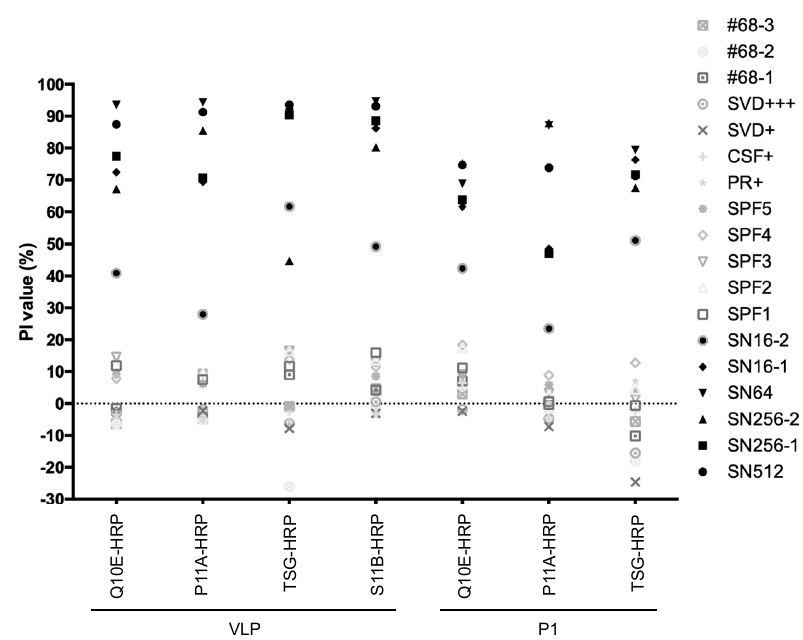
Figure 2. Specificity of VLP- and P1-based blocking ELISA paired with four MAbs. Samples included strongly positive anti-FMDV serum (SN512, SN256-1, SN256-2, and SN64), weakly positive serum (SN16-1 and SN16-2), SPF serum (SPF1, SPF2, SPF3, SPF4, and SPF5), anti-pseudorabies virus serum (PR+), anti-classic swine fever virus serum (CSF+), anti-swine vesicular disease virus serum (SVD+ and SVD+++), and FMDV-free samples (#68-1, #68-2, and #68-3). Each test was performed in